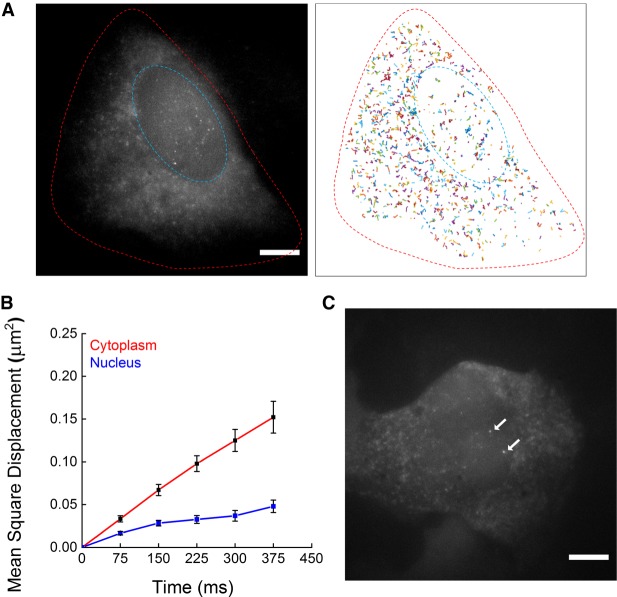
Single mRNA dynamics inside a living cell detected with the tripartite sfGFP system. (A) Fluorescence image of single mRNA molecules in a U2OS cell transfected with the tripartite sfGFP system. Nuclear mRNAs (inside the blue dashed line) are clearly visible, as well as mRNAs in the cytoplasm (between the red and blue dashed lines) (left). The trajectories of the mRNAs are shown in various colors (right). See Supplemental Movie S1 online. (B) The EAMSD curves of the mRNAs in the cytoplasm (red line) and the nucleus (blue line). Error bars represent SEM (n = 13 cells). (C) Two transcription sites detected inside a nucleus (arrows). See Supplemental Movie S2 online. Scale bars, 8 µm.